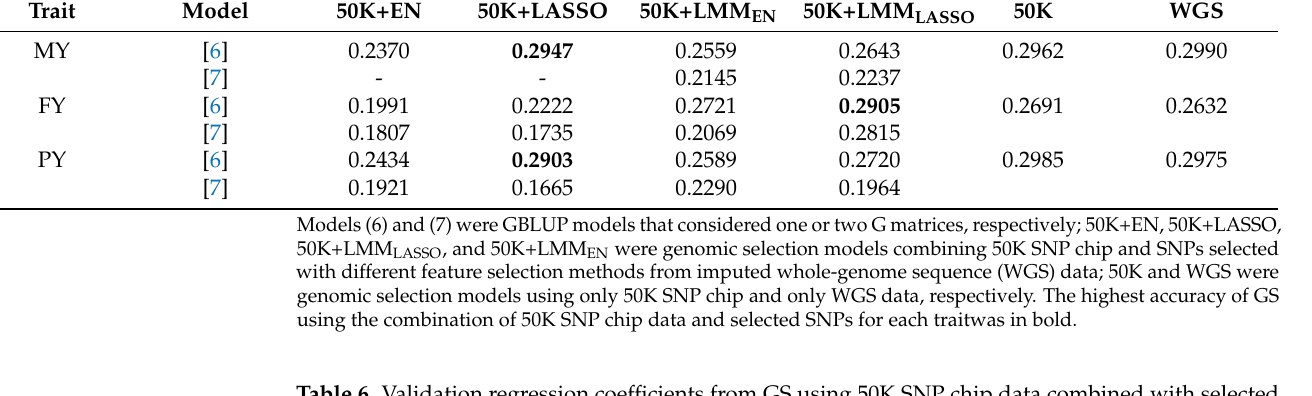
Table 6. Validation regression coefficients from GS using 50K SNP chip data combined with selected SNPs from WGS